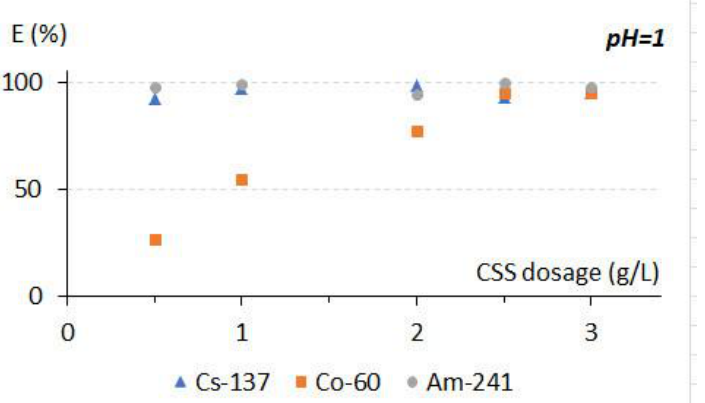
Figure 4. Dependence of the purification efficiency, E (%), of three radioactive metal cations on the CSS dose (g · L − 1